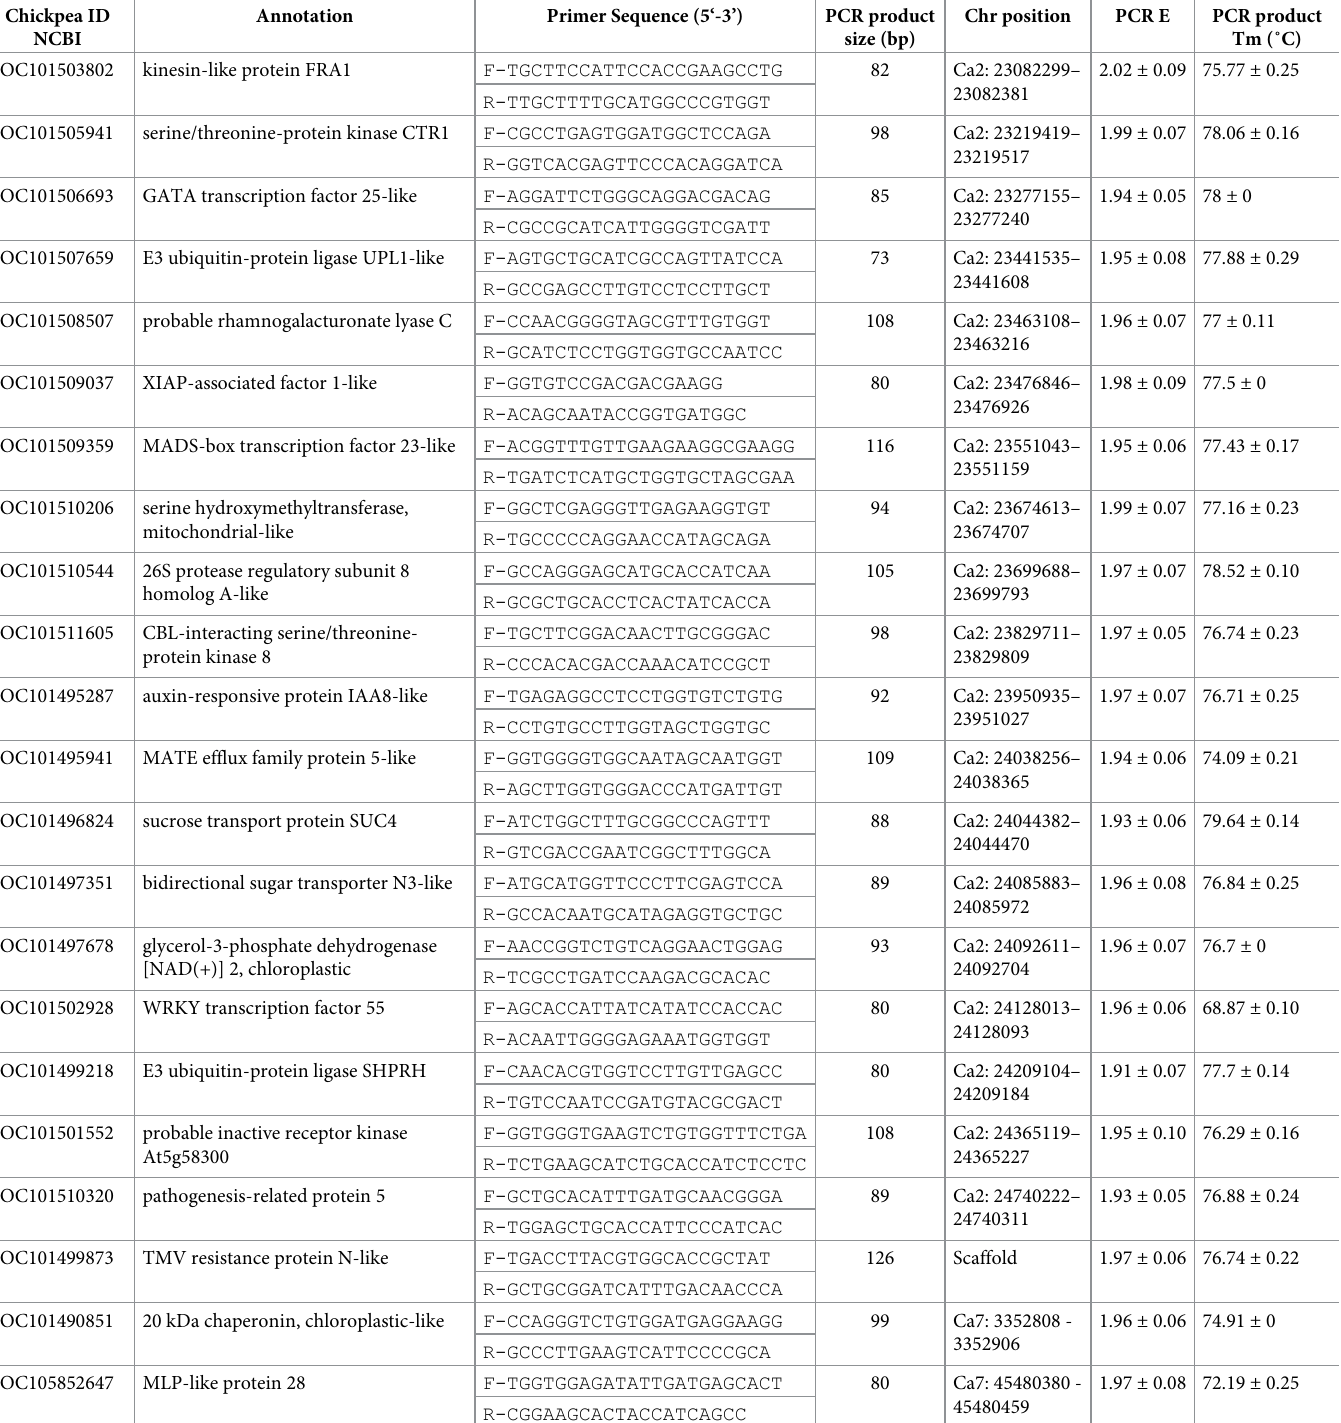
Table 1. Primers for RT-qPCR. Chickpea identifiers, annotation NCBI, primer sequences, amplicon size and chromosome position. Primer PCR efficiency and PCR product Tm data represent mean values ± sd. PCR efficiencies (E) calculated according to the equation (1 + E) = 10 slope